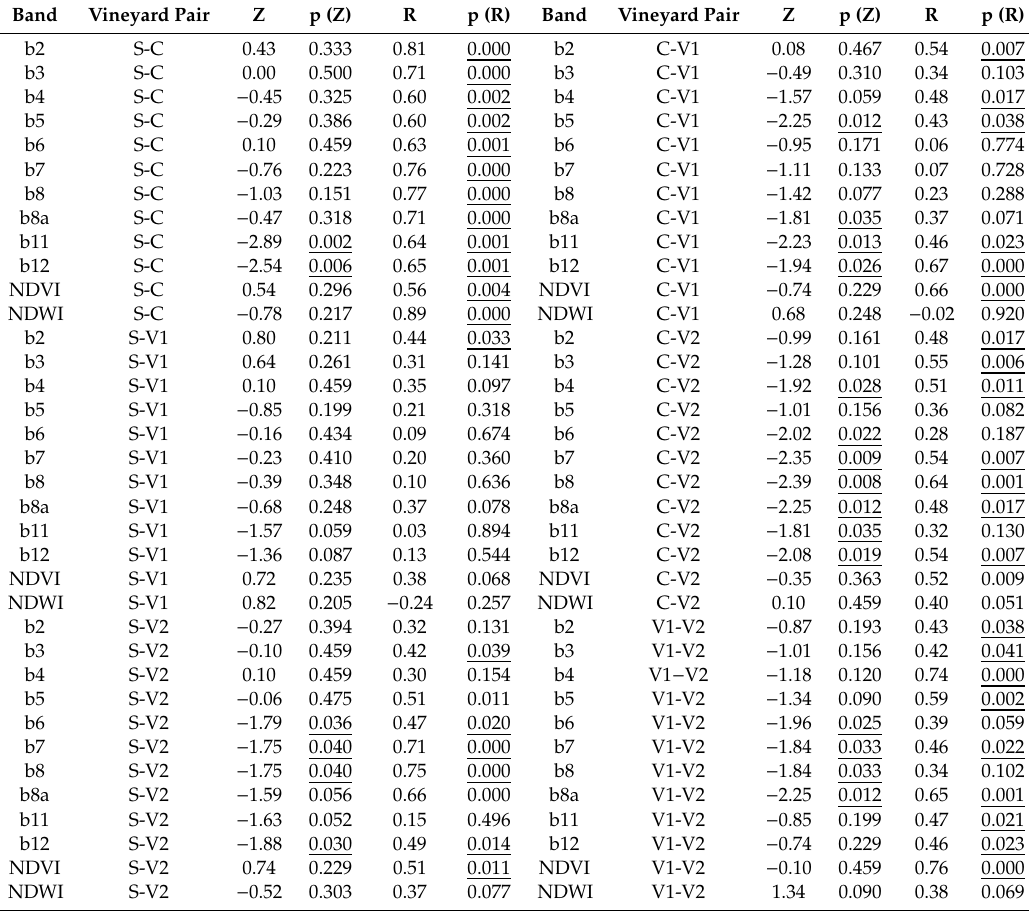
Table 3. Statistic parameters used to test similarity of temporal profiles of standard deviation of bands and indices (computed for each vineyard and date). Significance of di ff erences among profiles was tested by Wilcoxon rank-sum approach (Z statistic with correspondent probability p (Z)). Similarity of profile shapes was also tested by Pearson’s correlation (R with correspondent probability p